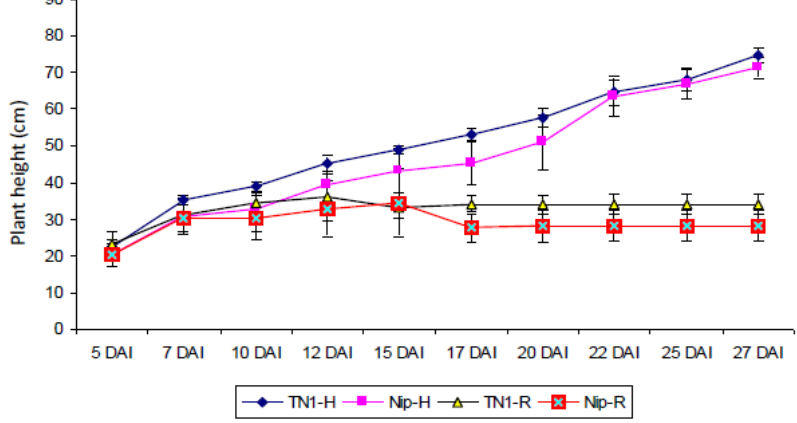
Figure 6. Comparison of plant size evolution between TN1 reference and Nip varieties in non-infected and RRSV-infected contexts. For each variety and condition, the size of approximatively 100 plants was followed for four weeks. RRSV inoculation was performed on 10-day-old plants. Non-infected healthy conditions are noted as –H (TN1-H and Nip-H). The infected condition is noted as –R (TN1-R and Nip-R). Time is reported in days after infection (DAI). The means of plant sizes are reported for each condition and error bars represent the standard deviation. Plant size is noted in cm.